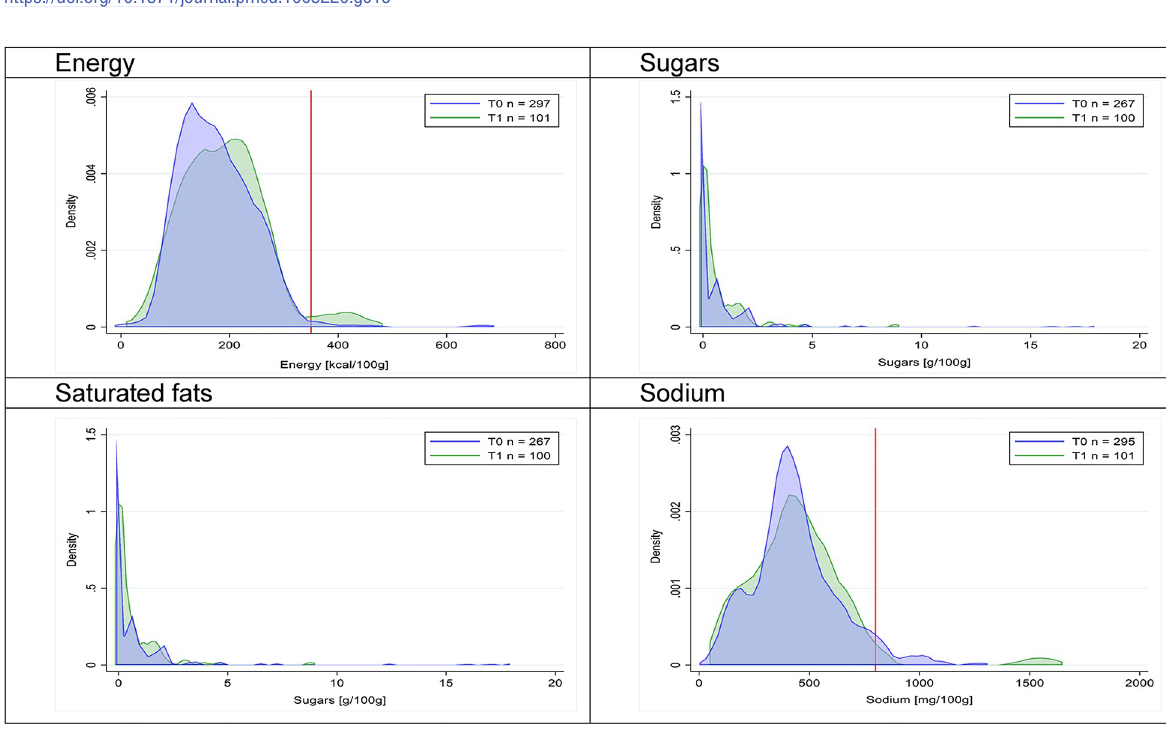
Fig 16. Density curves for the amount of energy and nutrients of concern in nonsausage meat products, cross-sectional samples. The blue line represents the distribution in T0 (preimplementation), the green line represents the distribution in T1 (postimplementation), and the red line represents the cutoff for the amount of energy or nutrients of